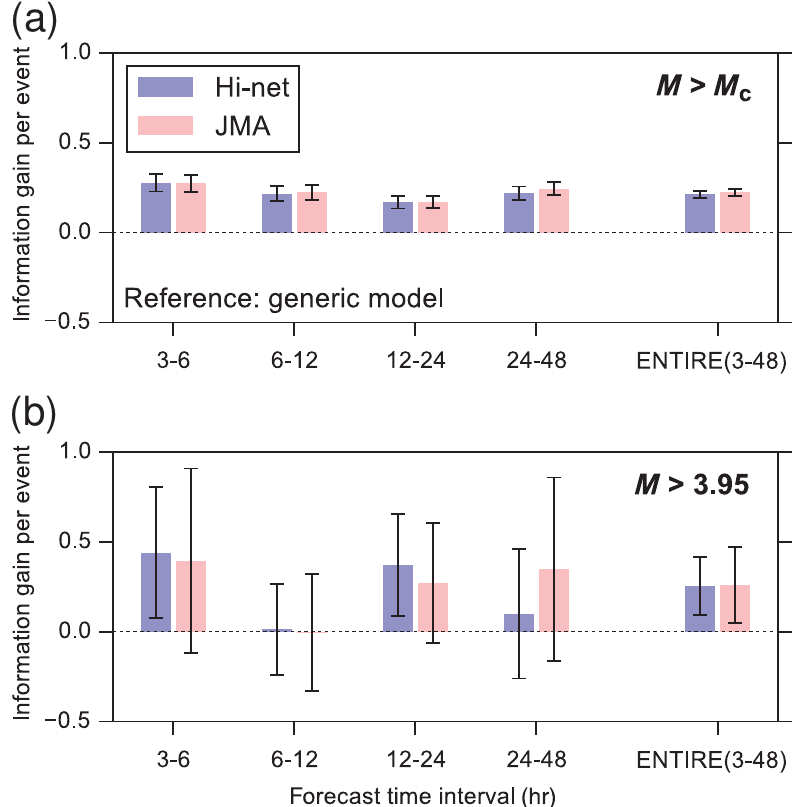
Figure 9. Information gain per aftershock of the forecasts based on the Hi-net and JMA catalogs, respectively, relative to the generic model for the cases with: ( a ) M t = M c ; and ( b ) M t = 3.95. If the lower bound of the error bar is greater than 0, the forecast is significantly better than the generic model with a probability larger than the 95%. From Omi et al.